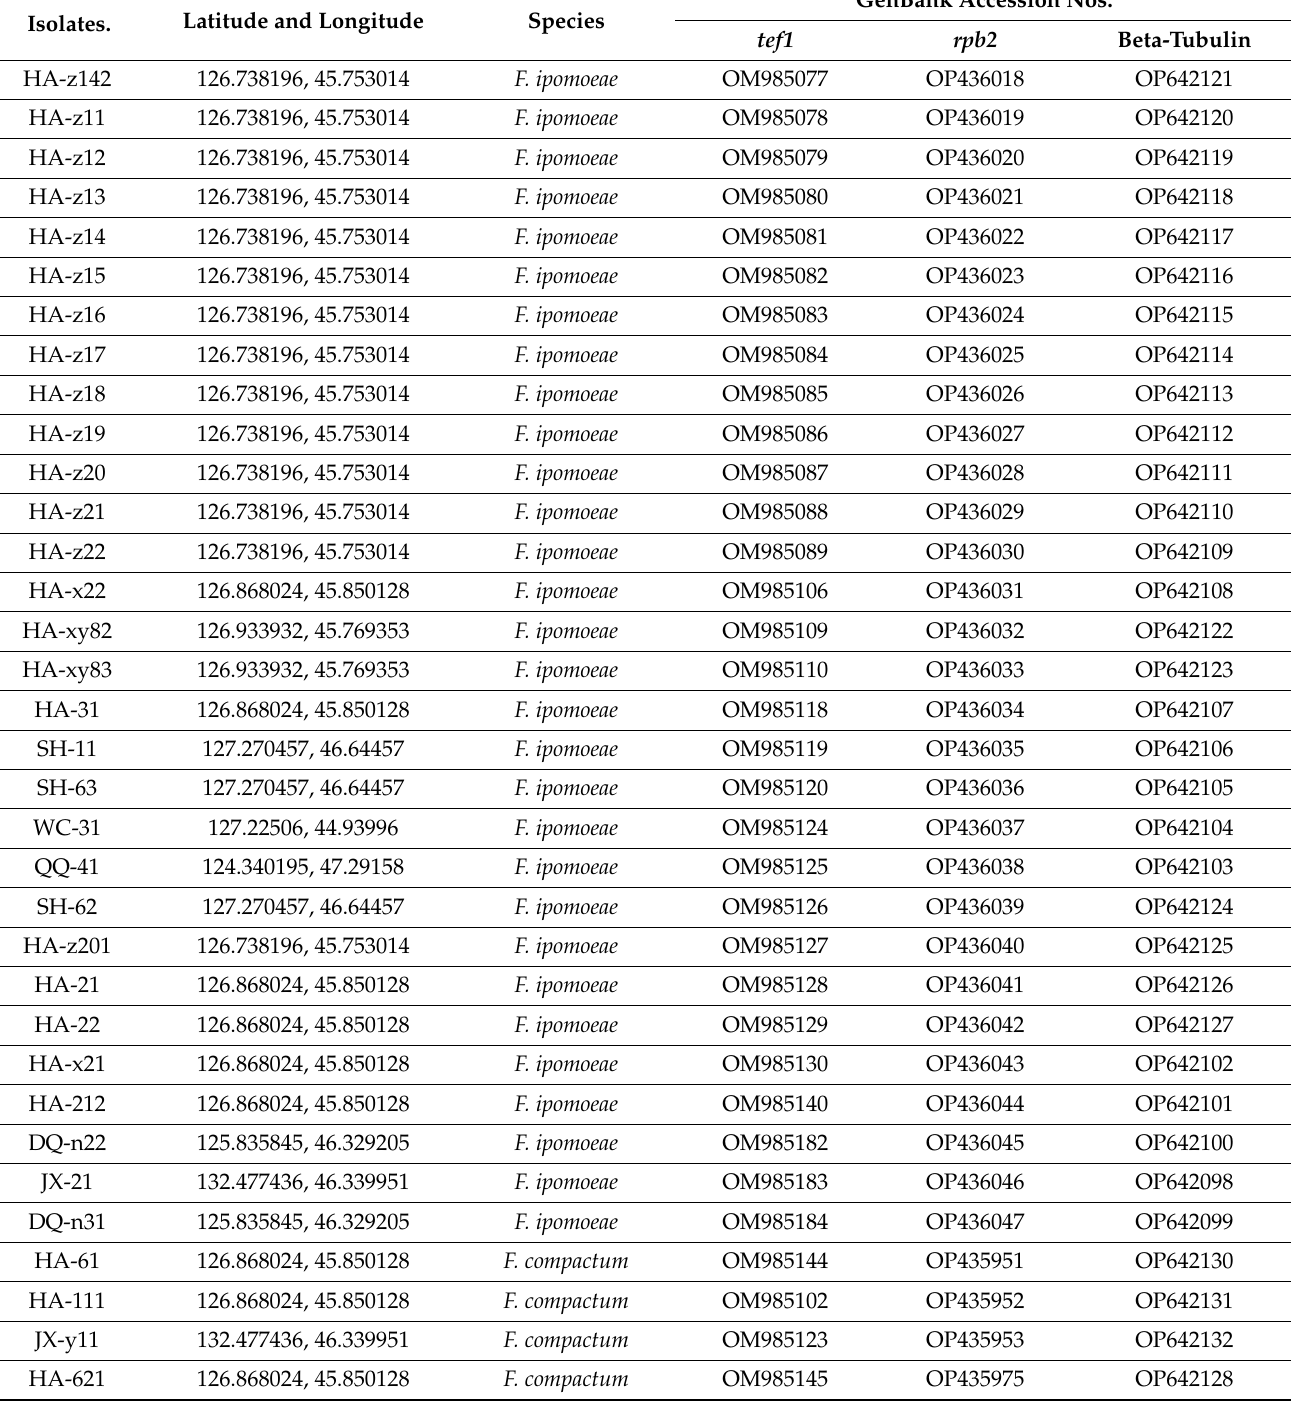
Table 1. List of GenBank accession numbers of Fusarium isolates obtained from symptomatic maize leaves collected from Heilongjiang province and reference strains used in this